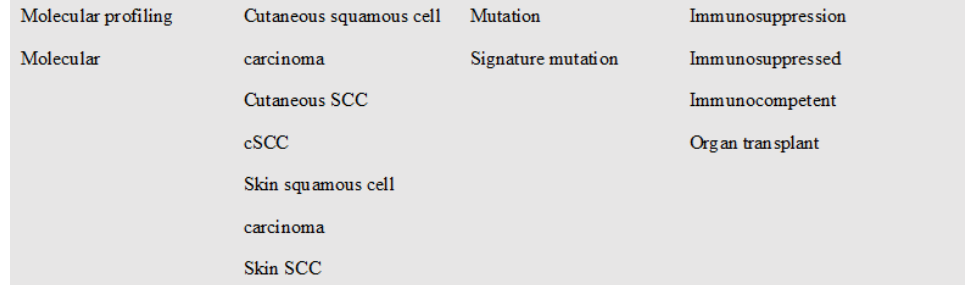
Figure 2. Representation of search terms used for the database search. Search terms within each box were connected by the Boolean operator OR. Each box represents a core search domain connected by the Boolean operator AND.